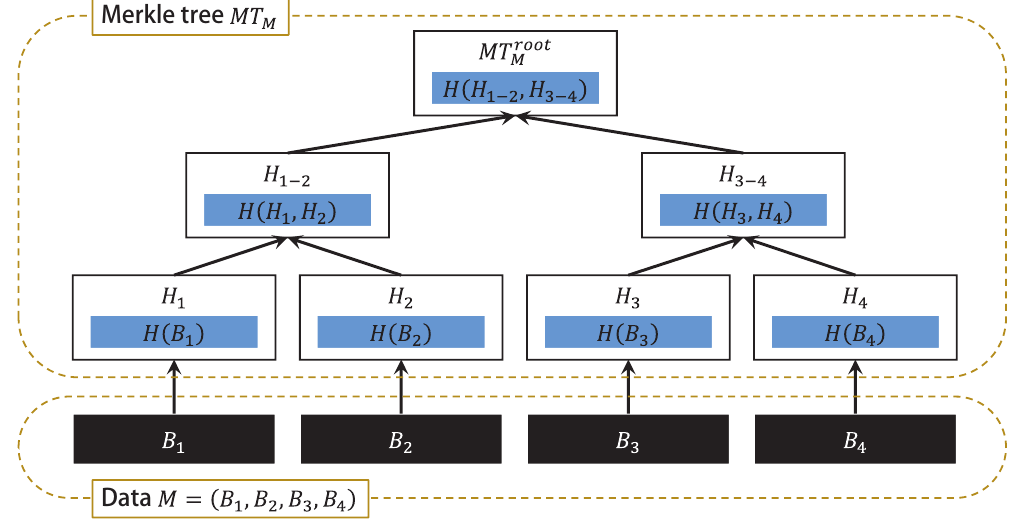
Figure 1. Merkle Tree of data M composed of four